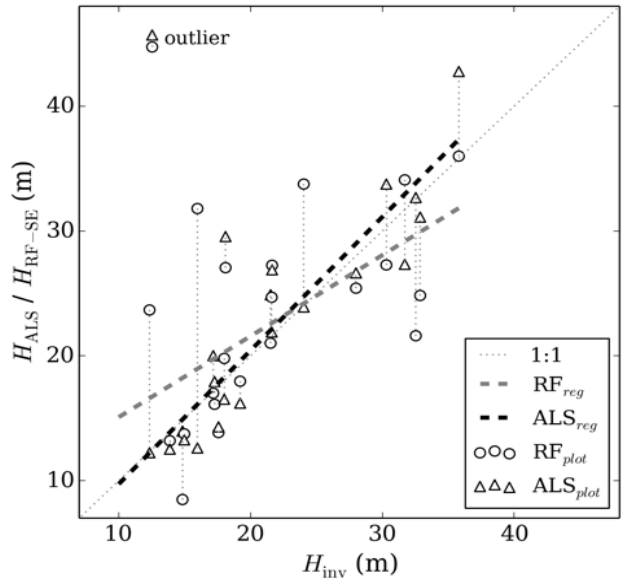
Figure 8. A comparison of inventory ( H inv ) measured canopy height and ALS ( H ALS ) and random forest-systematic error ( H RF-SE ) estimated canopy height, for 22 plots from within the ALS capture area. Vertical dotted lines link the same plot estimated with ALS or random